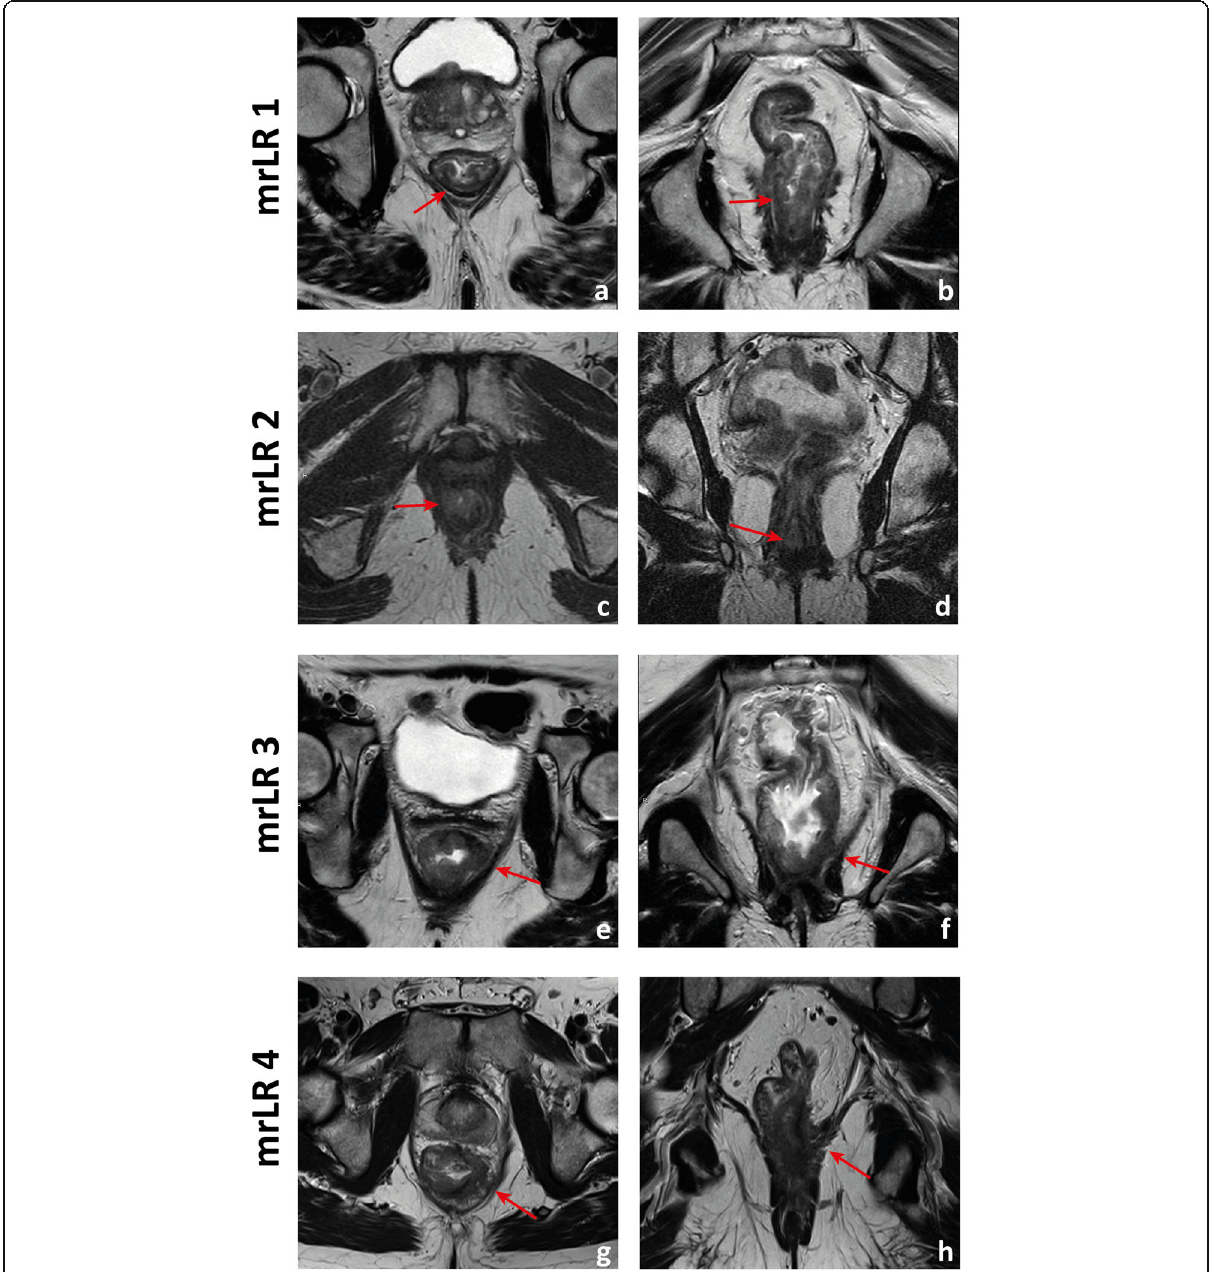
Fig. 20 Four low rectal cancers from 4 different patients are depicted. In a and b , a posterior mrT1sm3/early T2 tumour is depicted. It is classified as LR1 according to the low rectal cancer classification given it does not extend through the full thickness of the rectal wall. In c and d , a right anterior quadrant mrT2 tumour extending inferiorly into the anal canal is depicted, which invades the full thickness of the internal anal sphincter without extending into the intersphincteric plane — mrLR2. In e and f , a T3 tumour extending into the low mesorectum to within 1 mm of the left levator muscle is classified as mrLR3; in g and h , a low tumour extends through the mesorectal fat reaching the left levator muscle, therefore classified as